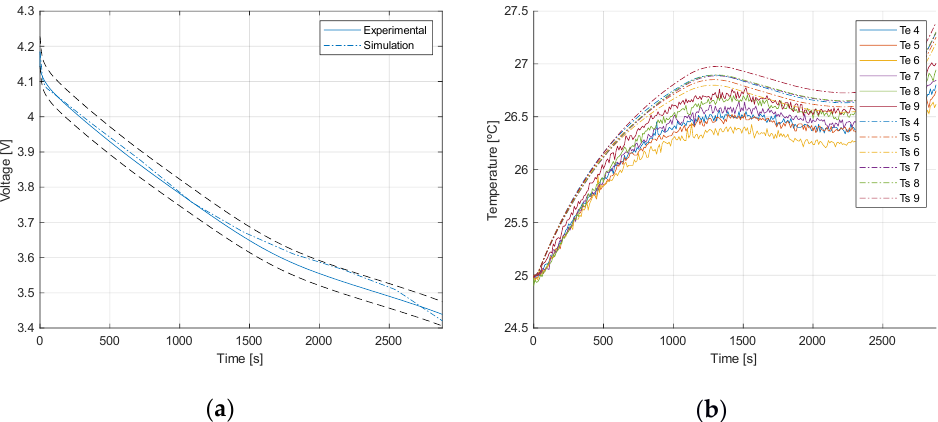
Figure 3. Battery cell model validation with experimental ( a ) voltage and ( b ) surface temperature distribution in a range of 100–20% SOC of a 1C discharge test.